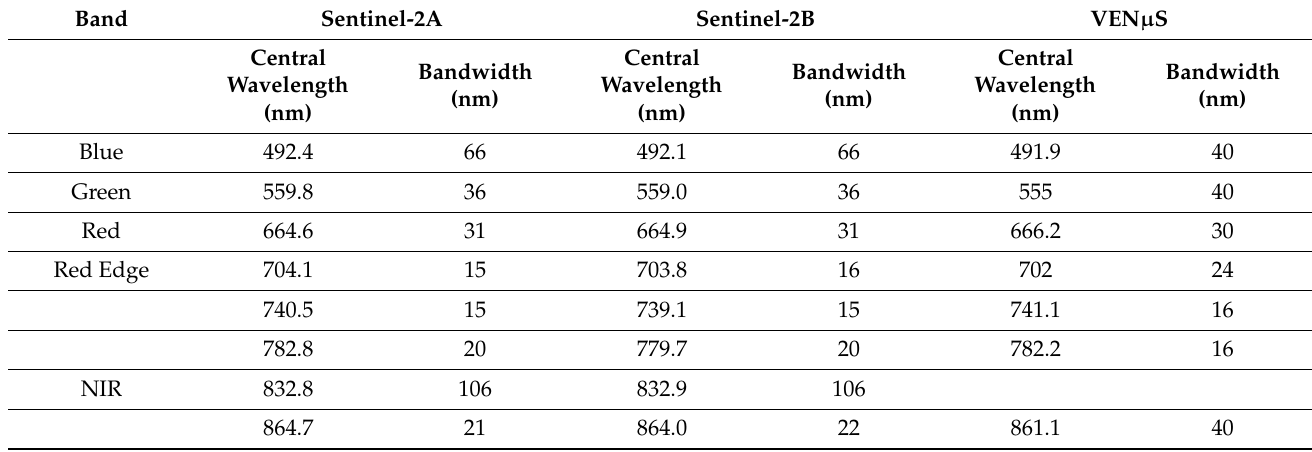
Table 2. Central wavelengths and bandwidths (nm) of Sentinel-2 and VEN µ S equivalent bands used in this study.